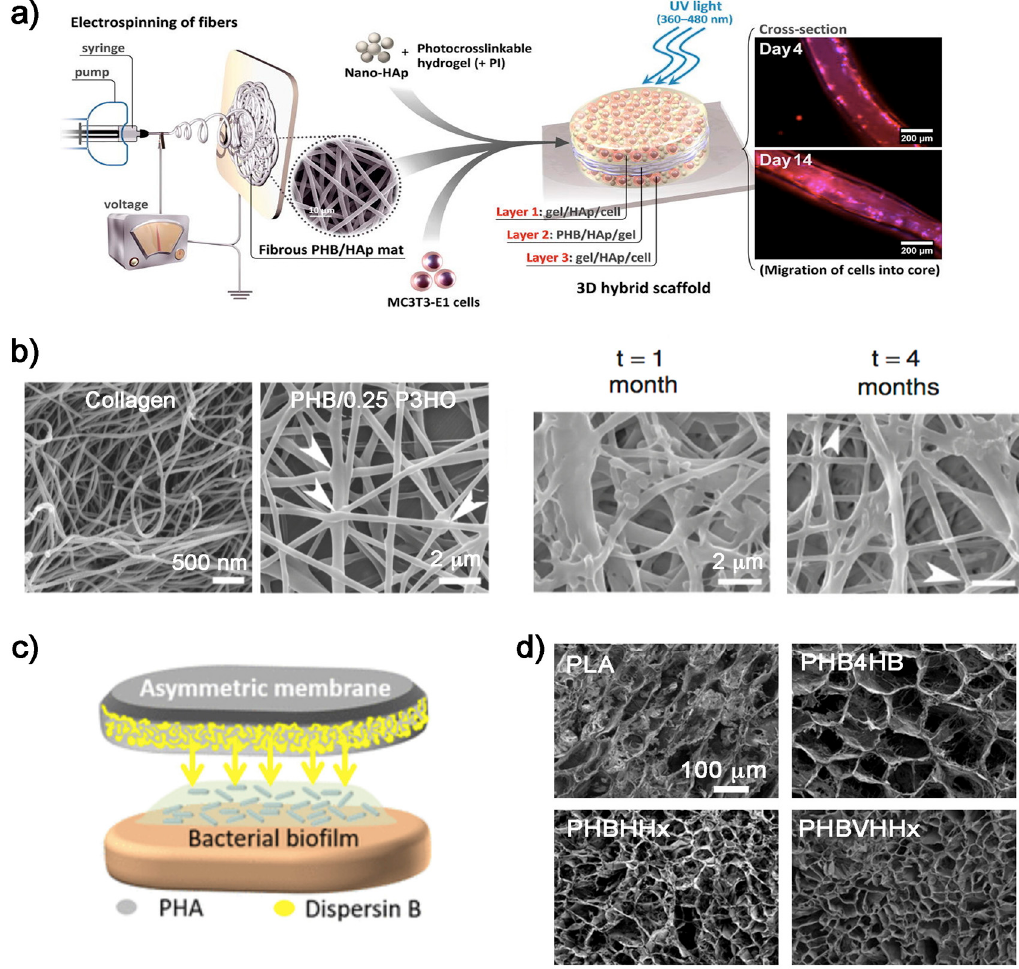
Figure 2. PHAs for tissue engineering: ( a ) Scheme of the published study of Sadat-Shojai et al. [39] where a cell-laden tri-layered scaffold of PHB with hydroxyapatite (HA) was performed to enhance bone regeneration in vivo. ( b ) Scanning electron microscopy (SEM) micrographs of PHB/P3HO scaffolds where the electrospun fibers with a ratio blend of 1:0.25 provided structures more similar to collagen natural fibers. Biopolymeric fibers after hydrolytic degradation [41]. ( c ) Scheme of the asymmetric PHA membranes entrapping an anti-biofilm protein (dispersin B) for wound healing [49]. ( d ) SEM micrographs of biopolymers scaffolds from Li et al. [50]. The biopolymer structures displayed different pore sizes where stem cells were loaded into, and the PHBVHHx ones exhibited the highest cell attachment.